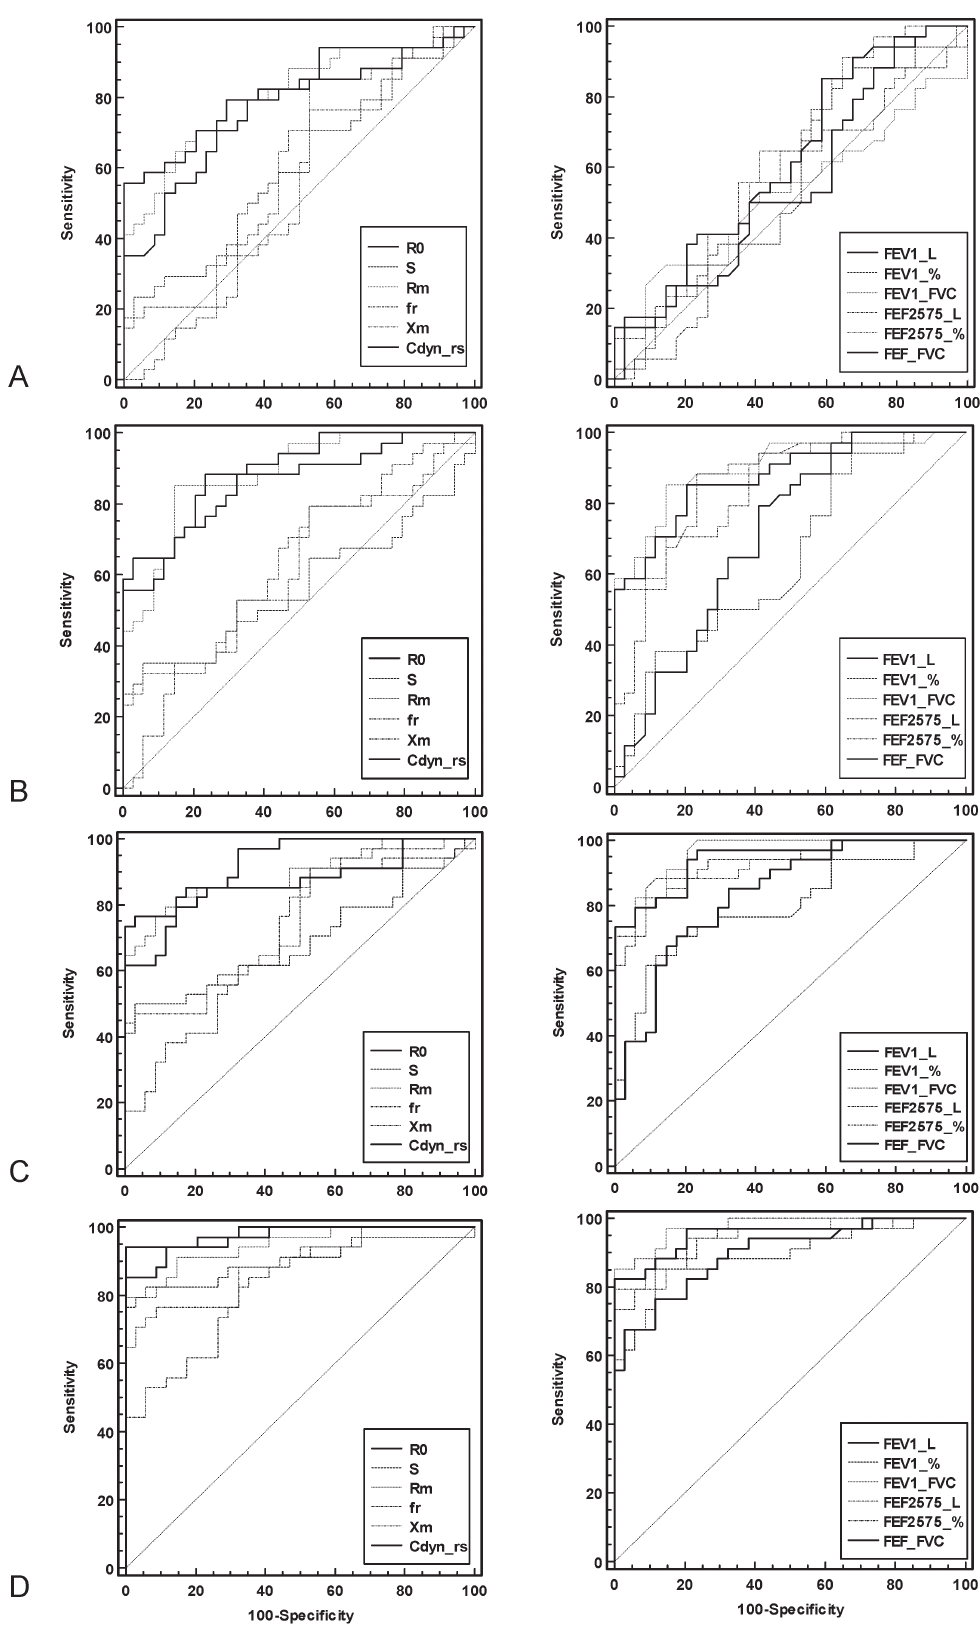
Figure 3 - Receiver operating characteristic (ROC) curves of FOT (left) and spirometric (right) parameters obtained considering the, , 20 pack-years (A), 20-39 pack-years (B), 40-59 pack-years (C), and . 60 pack-years (D) groups.